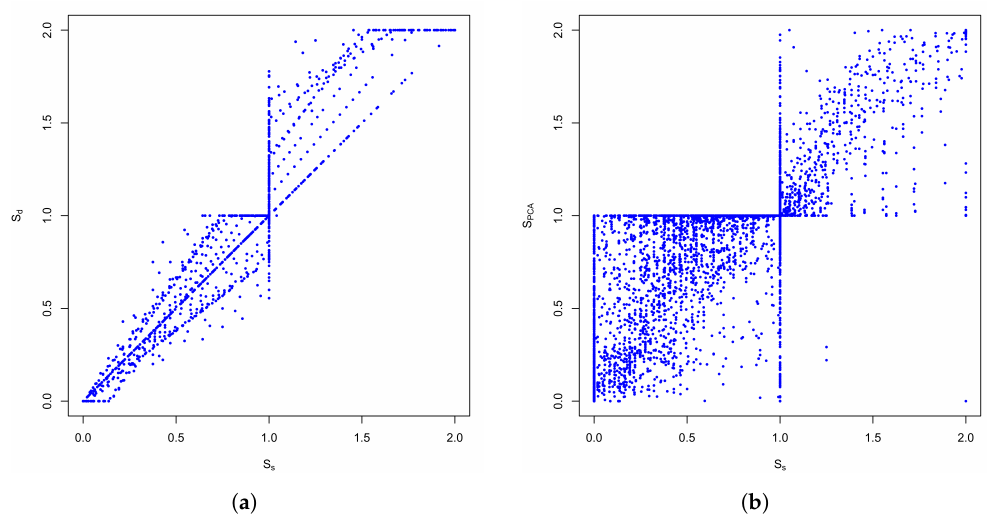
Figure 10. Scatter plot of performance index from two methods, ( a ) directional score, S d against the simple score S s , and ( b ) PCA score S PCA against S s